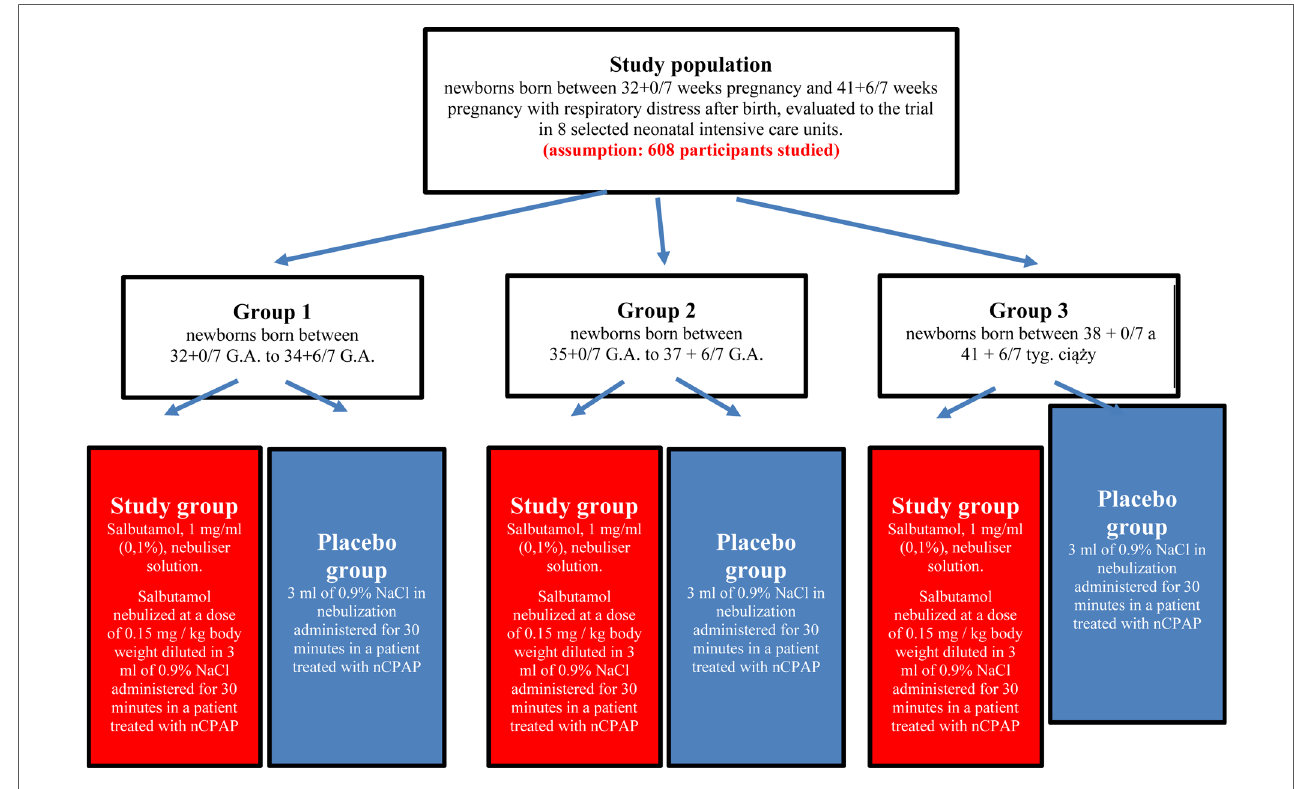
FIGURE 1 Characteristics of the study group and interventions ’